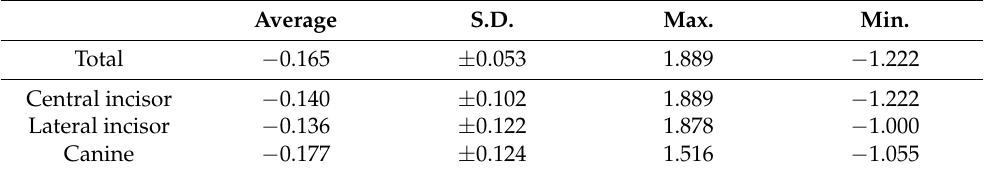
Figure 3. The color displacement map of the root position of case 2 and case 4. The green (zero point) indicates that the test method and the current method had no displacement. The red indicates the outward displacement of the test method compared to the current method. The blue indicates the inward displacement of the test method compared to the current method. Table 1. The average root displacement of each tooth type.